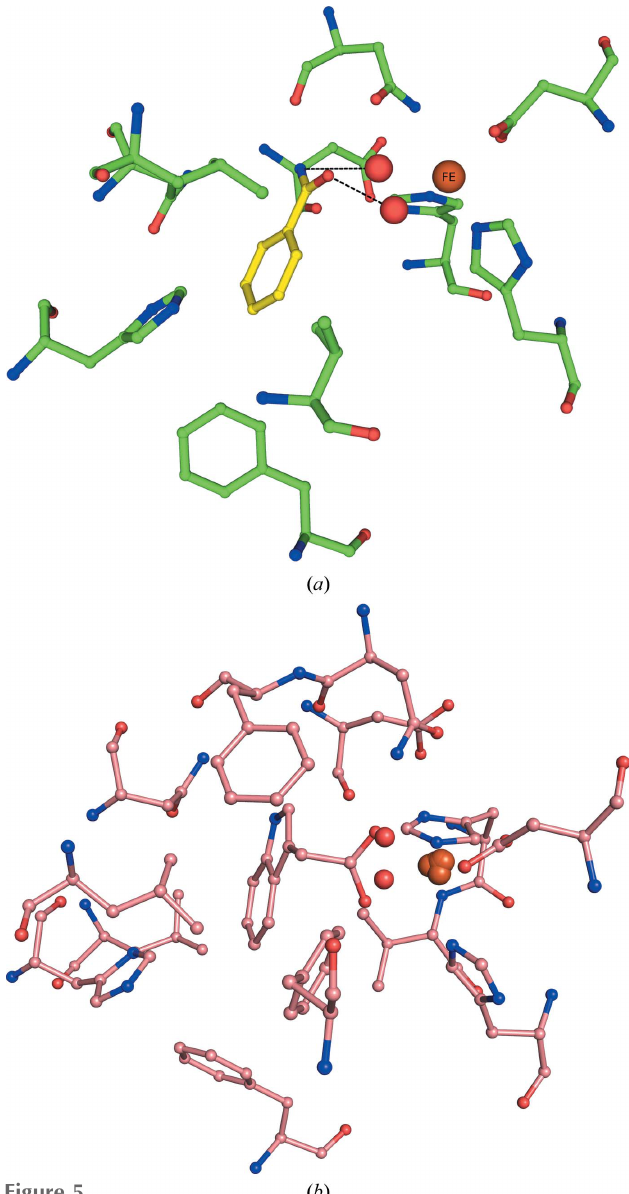
Figure 5 ( a ) Active-site residues of NDO with benzamide (yellow) bound are represented by sticks with green C atoms. The mononuclear iron (large orange sphere) and modeled dioxygen from PDB entry 1o7n (small red spheres) are also shown. ( b ) Active-site residues of NDO bound to indole-3-acetate. The mononuclear iron (large orange sphere) and modeled dioxygen from PDB entry 1o7n (small red spheres) are also shown.